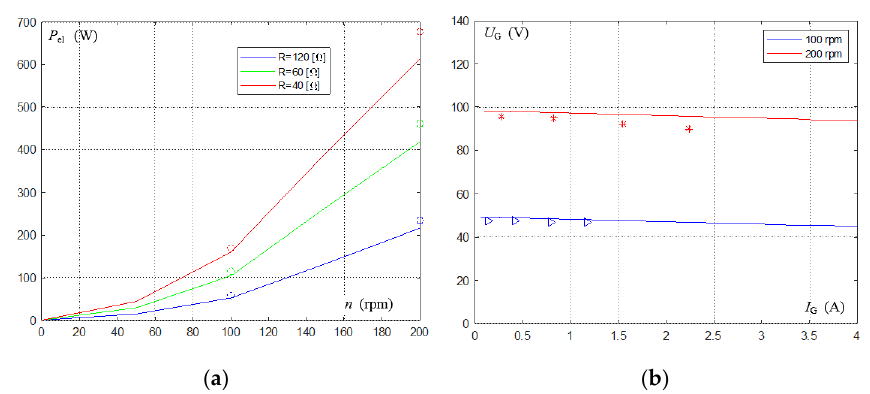
Figure 29. ( a ) Generator G3-power as a function of rotational speed for different resistive loads; ( b ) generator G3-voltage as a function of current for selected rotational speed values; points-measurement results, solid line-analytical calculations.